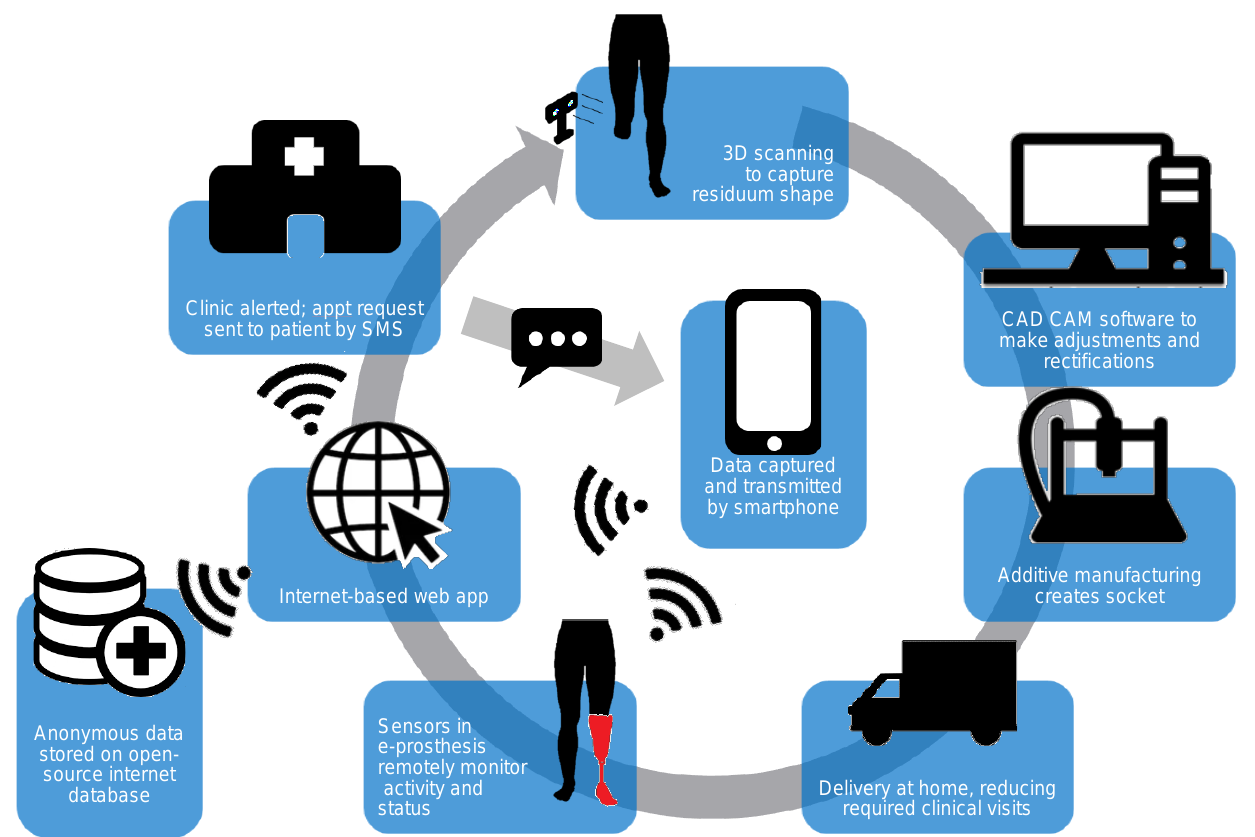
Figure 3 : “Servitisation” model for Local/Satellite and central fabrication. Pilot study illustration from MovAid 13